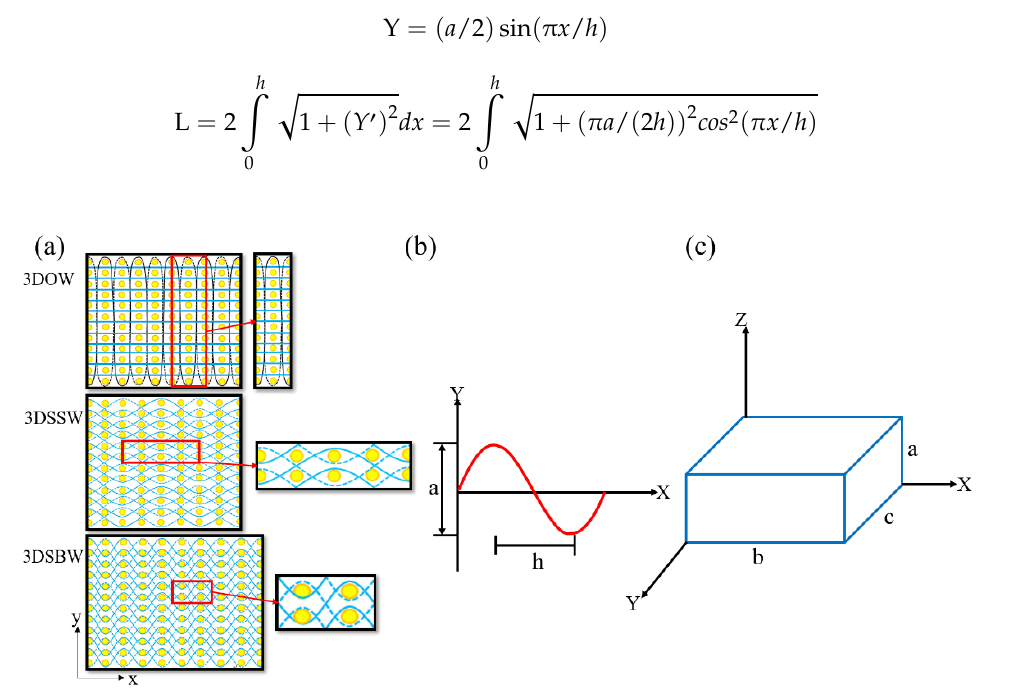
Table 1. The specifications of 3D woven fabric.